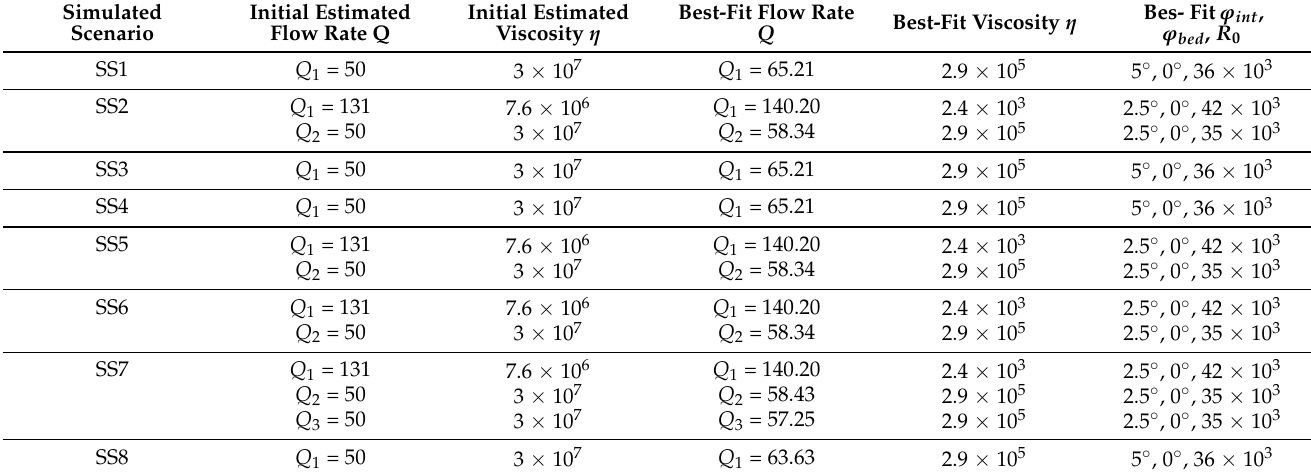
Table 3. Arbitrary initial lava emission flow rate Q (m 3 /s) from vents, and apparent viscosity η (Pa s) from morphometric analyses used for calibration through simulation. Simulation flow rate Q and rheological characteristics (viscosity, friction angles ( ◦ ), and yield strength (Pa)) estimated from calibrations in each scenario (SS* in Table